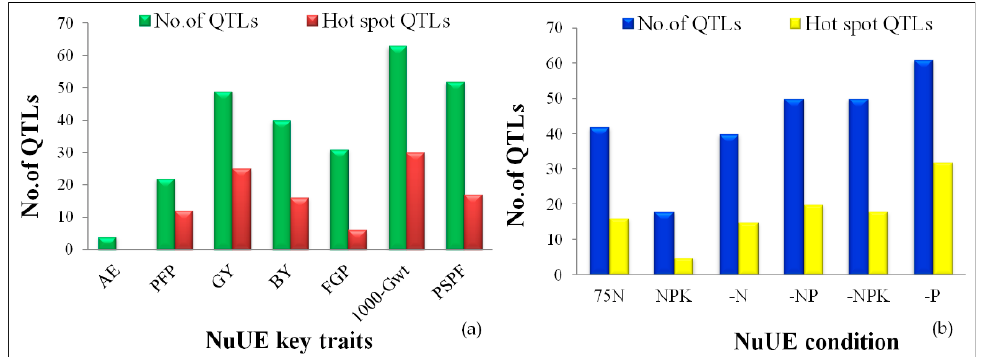
Figure 2. Distribution of trait-wise ( a ); and NPK combinations ( b ), associated with a total number of quantitative trait loci (QTLs) and hotspot QTLs in different nutrient conditions in rice.